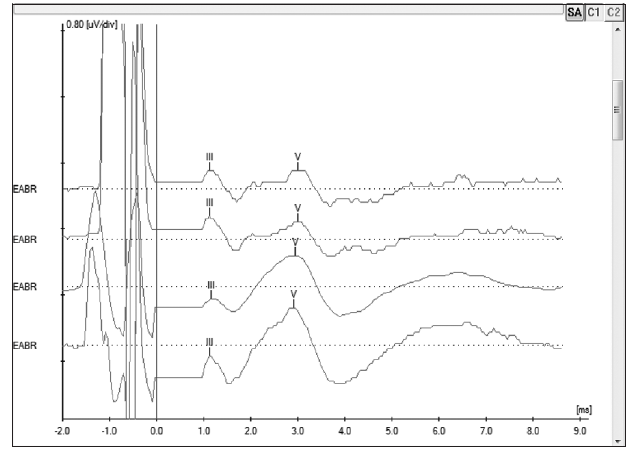
Figura 4. Registro dos potenciais de tronco cerebral evocados eletricamente medidos na etapa intraoperatória do sujeito 5 para os demonstrando estimulação efetiva das fibras neurais.